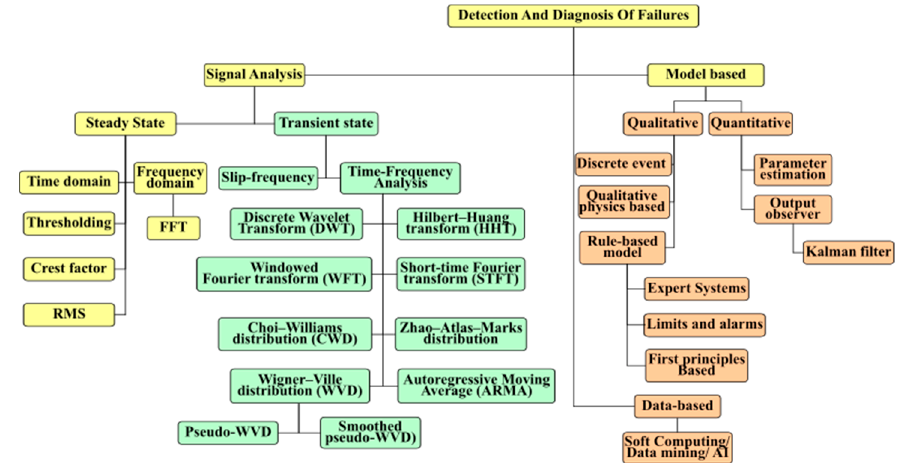
Figure 8. Models Applied for the Detection and Diagnosis of Failures. Source [105–108], own elaboration.